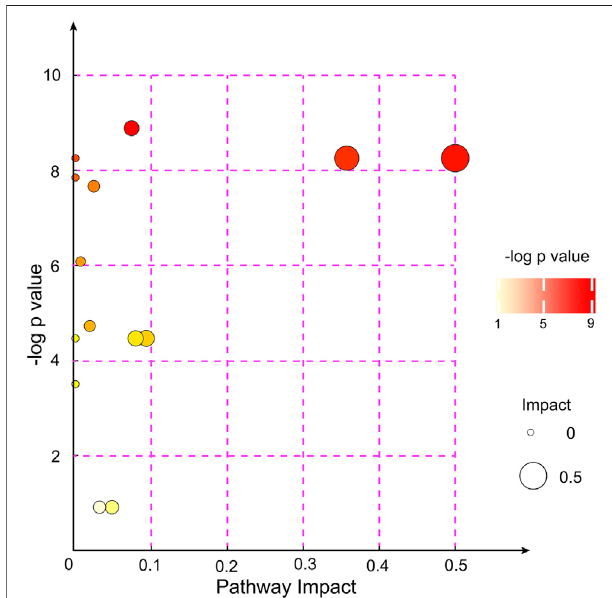
FIGURE 4 | KEGG pathway enrichment analyses of the 31 altered metabolites between the EA group and the non-EA group. Each bubble represented a pathway, and 14 pathways were included in this bubble plot. The bubble size indicated the impact factor of the pathway in the topology analysis, and the bigger the size, the larger the impact factor. The bubble color represented the enrichment degree, and the deeper the color, the smaller the p value, indicating more signi fi cant